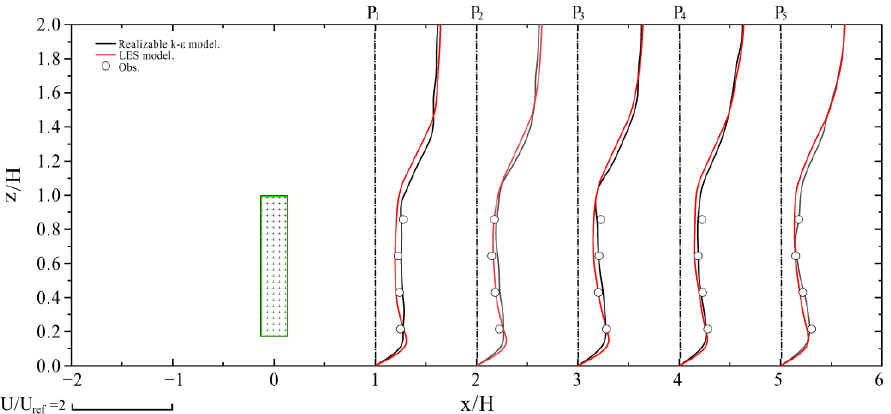
Figure 3. Comparison of simulated and measured profiles of mean wind speed behind the row of canopy. The green rectangular marks the canopy region occupied by trees.